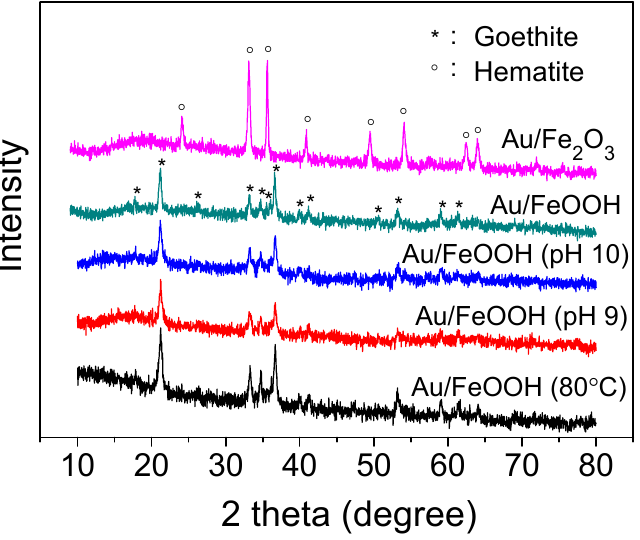
Figure 3. X-ray diffraction patterns of gold catalysts.